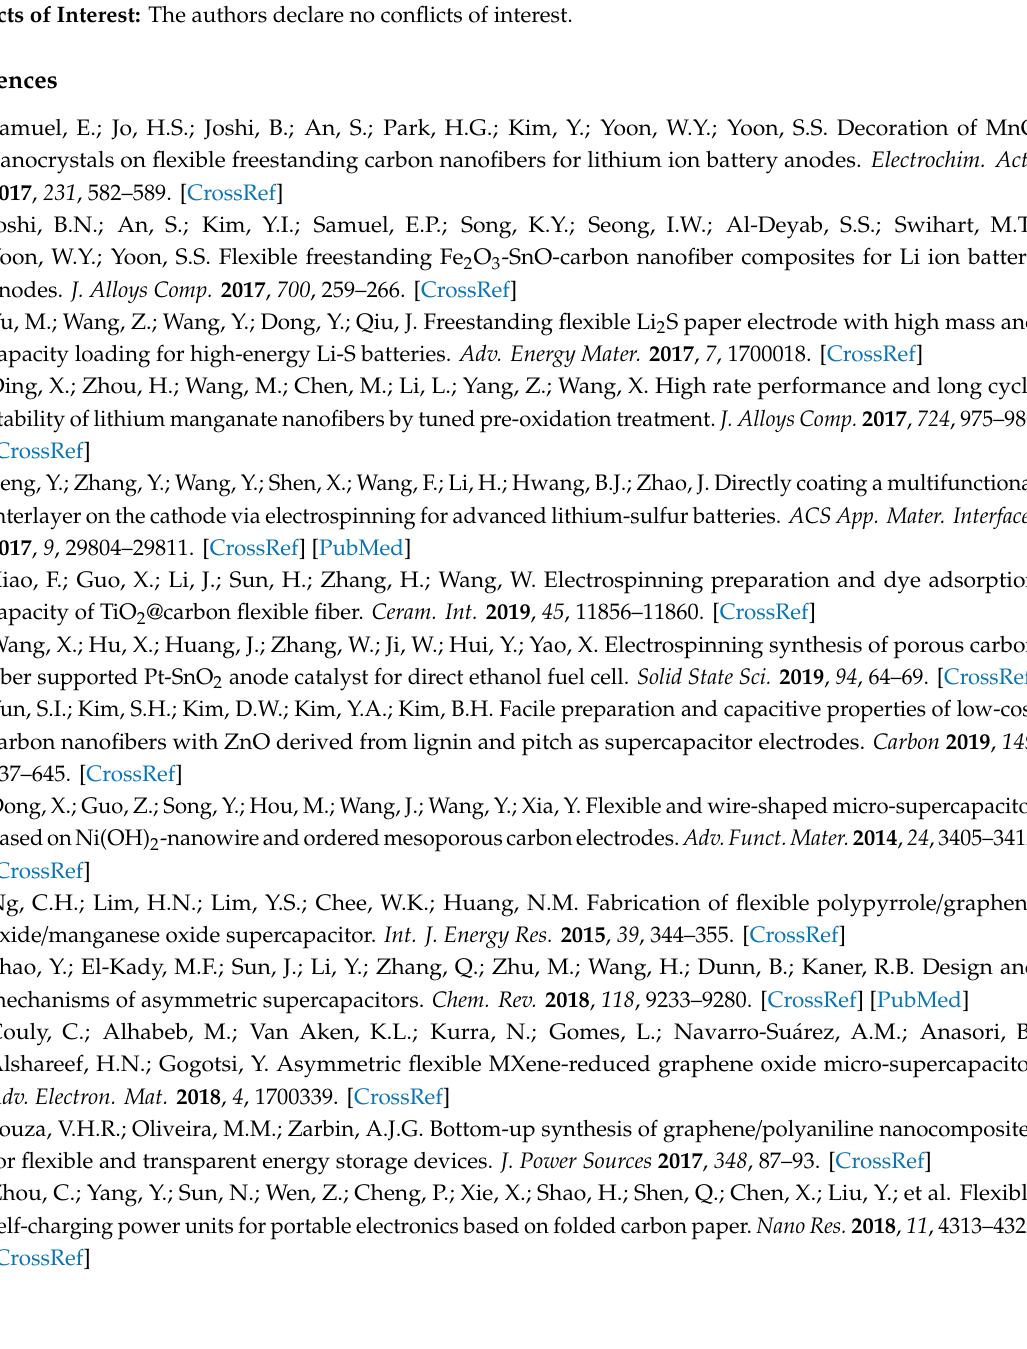
Figure S1: SEM image of PAN-derived carbon nanofiber mats of the sample C-1 with a high magnification, Figure S2: SEM images of PAN-derived carbon nanofiber mats of the sample C-2 (a), C-3 (b) and C-4 (c) with a high magnification, Figure S3: SEM images of PAN-derived carbon nanofiber mats of the sample C-5 (a) and C-6 (b) with a high